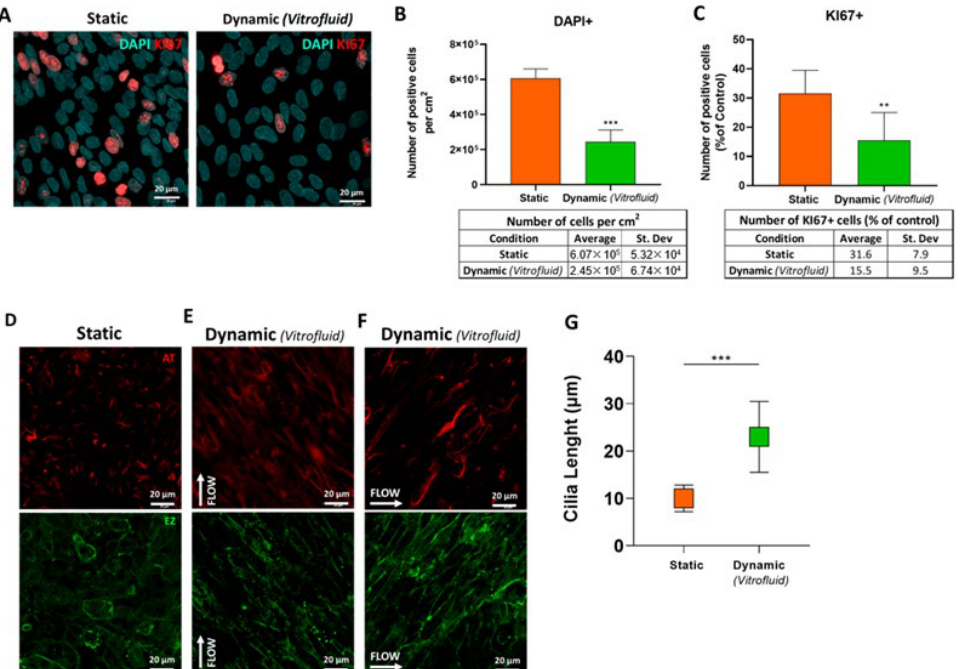
Figure 7. Effect of FSS on cell proliferation, cilia morphology and orientation: ( A ) Proliferating RPTECs under static and dynamic culture conditions on day 7 were stained with Ki67 (red) and DAPI (nuclei, cyan); n = 2 biological repeats in technical triplicates; Student’s t -test. ( B ) Average of RPTEC nuclei per cm 2 cultured under static and dynamic conditions on day 7 (mean ± SD; three biological repeats in technical triplicates; Student’s t -test; *** p ≤ 0.001). ( C ) Average of Ki67+ nuclei after 7 days under static or dynamic conditions shown as a percentage of control (number of total nuclei per condition) (mean ± SD; two biological repeats in technical triplicates; Student’s t -test; ** p ≤ 0.01). ( D – F ) Immunostaining of acetylated tubulin (red) and ezrin (green) showing that cilia follow different flow directions: Static conditions ( D ), flow conditions for 3 days following the direction of the arrow €, and after rotation of the insert by 90° (as indicated by the arrow) and a further 3-day incubation ( F ). ( G ) Average cilia length measured with ImageJ software (mean ± SD; n = 3; Student’s t -test; *** p ≤ 0.001).